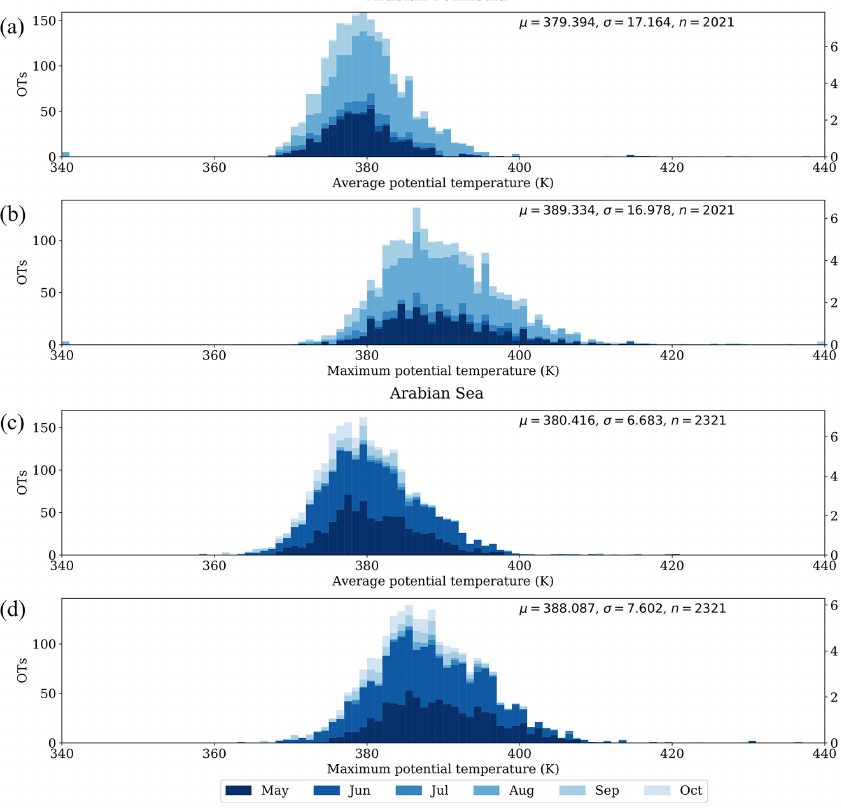
Figure 8. As Fig. 5, but for the potential temperature distributions of OTs over the Arabian Peninsula region (a, b) and the Arabian Sea region (c, d)